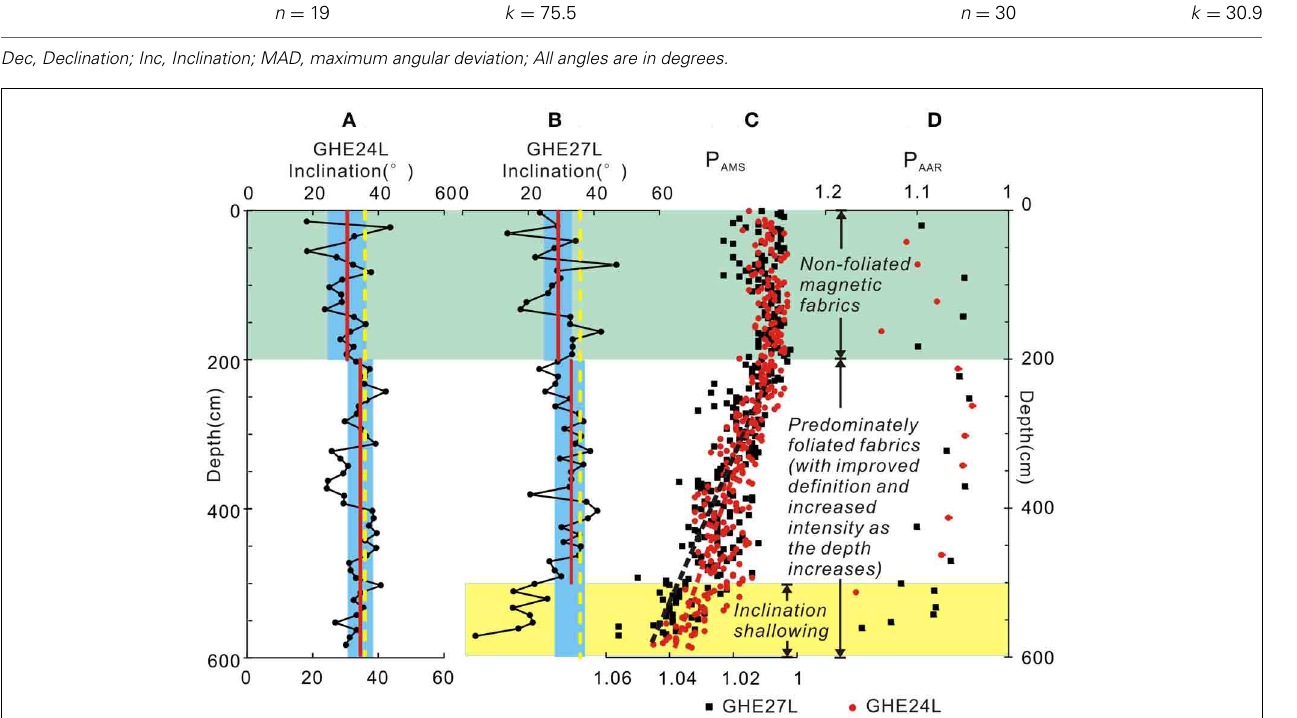
corresponding segments and the expected inclinations of the geocentric axial dipole (GAD) field at the sites. The dashed lines in (C) represent the linear regression lines for GHE24L and GHE27L sediments,